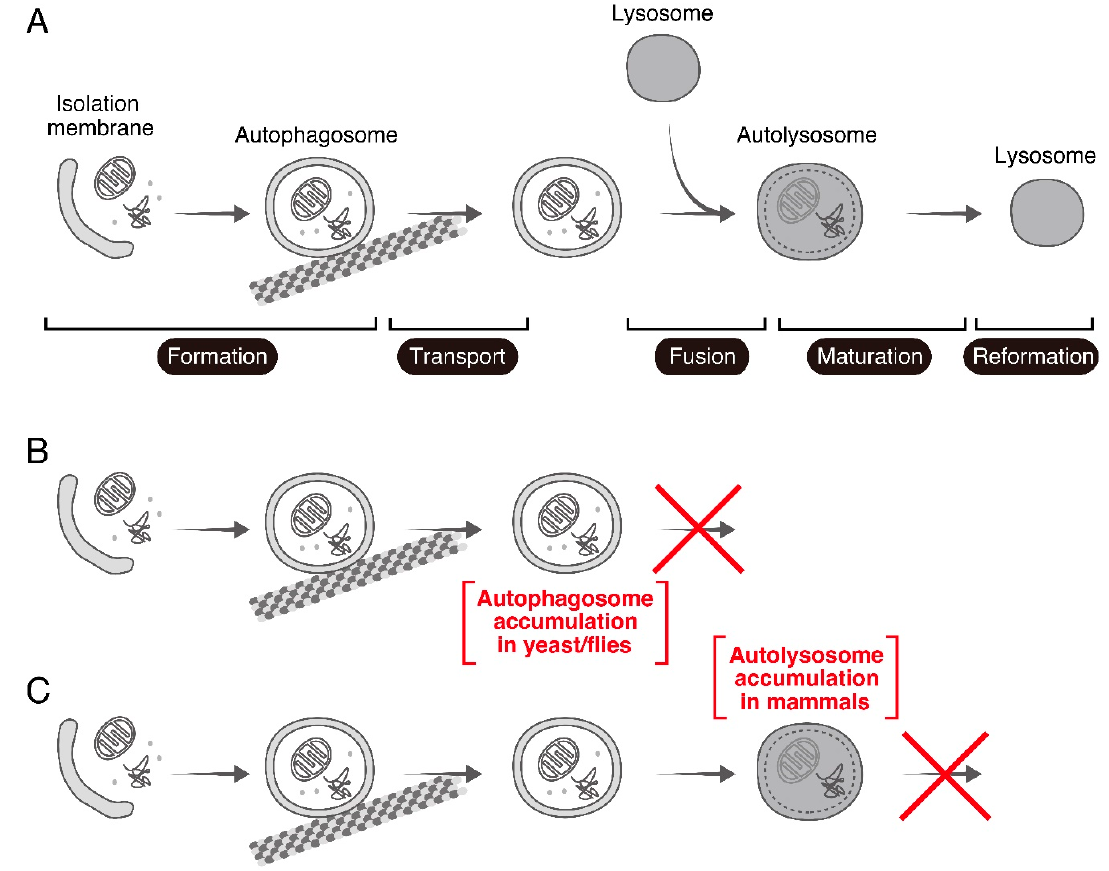
Figure 1. Overview of autophagy and the autophagic phenotypes reported in Rab7-KO yeast/fruit flies and mammals. ( A ) Overview of autophagy. Upon induction of autophagy by stresses such as nutrient starvation, an isolation membrane emerges in the cytoplasm and sequesters cytoplasmic contents to form an autophagosome (formation step). The autophagosome is delivered to the perinuclear region along microtubules (transport step), where it fuses with a lysosome to form an autolysosome (fusion step). Energy is supplied by degradation of the cargos sequestered in the autolysosome (maturation step), and, finally, a new lysosome is formed (reformation step). ( B ) Accumulation of autophagosomes in Ypt7-KO yeast and Rab7-KD fruit flies, suggesting that Rab7/Ypt7 regulates the autophagosome-lysosome fusion step. ( C ) Accumulation of autolysosomes in Rab7-KO mammalian cultured cells, suggesting that mammalian Rab7 regulates the autolysosome maturation